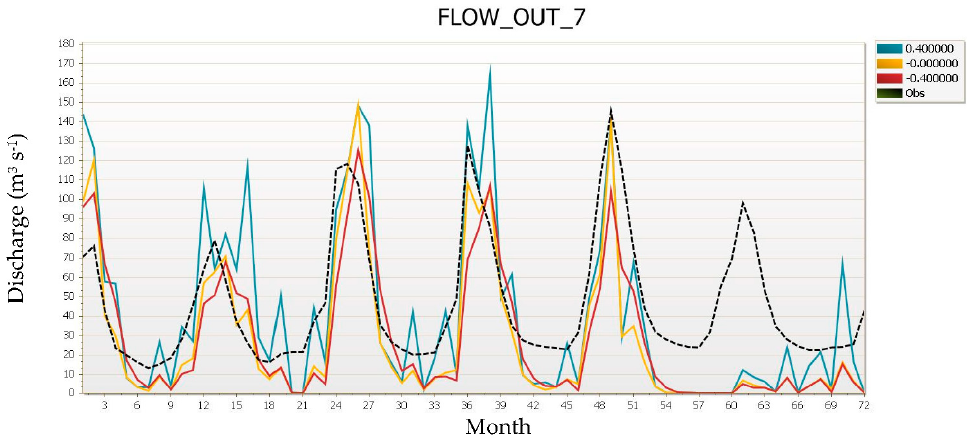
Figure 1. Sensitivity of discharge to three different values of CN2 in one ‐ at ‐ a ‐ time (OAT) analysis. The term calibration refers to a procedure where the difference between model simulation and observation are minimized. Through this procedure, it is hoped that the regional model correctly simulates true processes in the physical system (Figure 2).